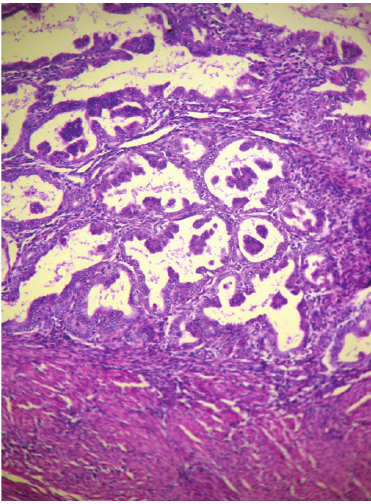
Figure 3: Endometrioid adenocarcinoma FIGO Ia (grade 1). Hema- toxylin eosin